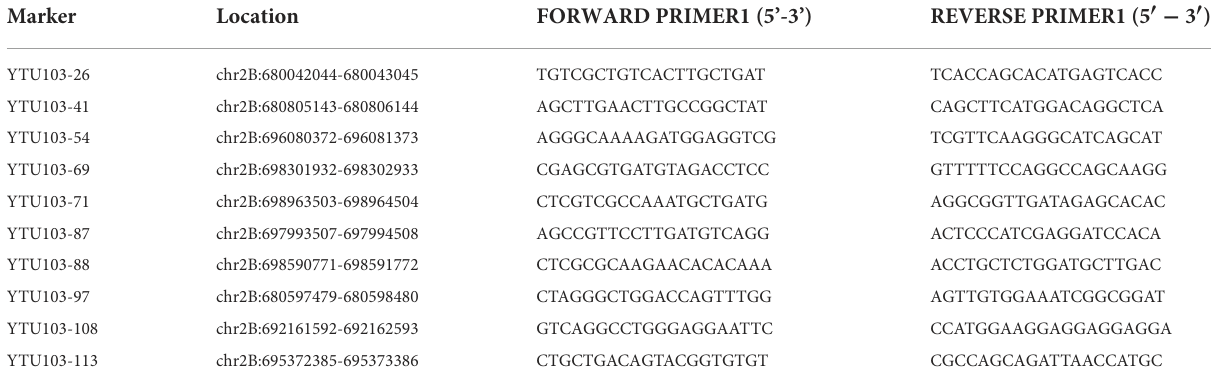
TABLE 4 pmYN99102 -linked markers developed by bulked segregant exome capture sequencing (BSE-Seq). Marker Location FORWARD PRIMER1 (5’-3’) REVERSE PRIMER1 (5